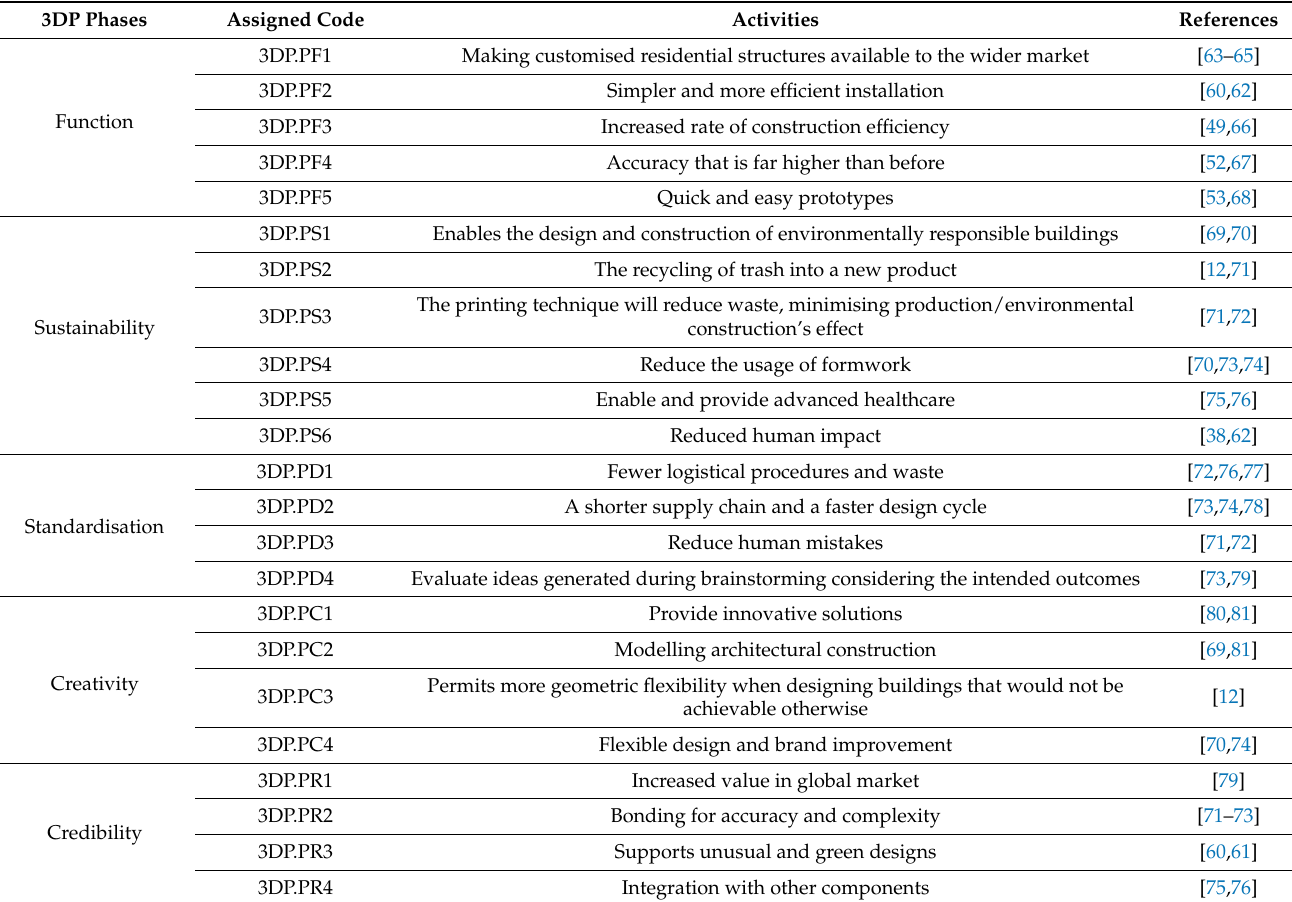
Table 1. Three-dimensional printing impact factors evident from existing